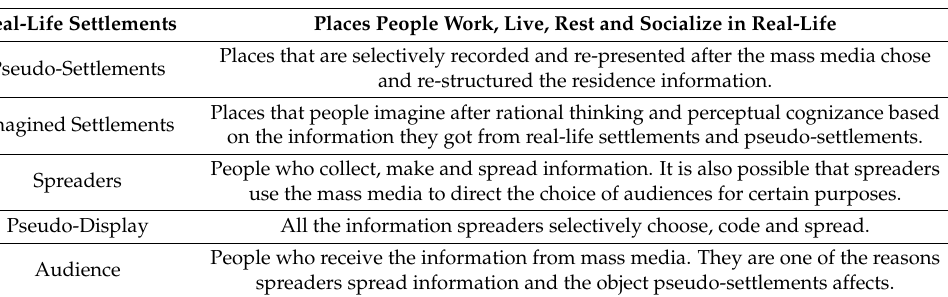
Table 1. Explanations to concepts